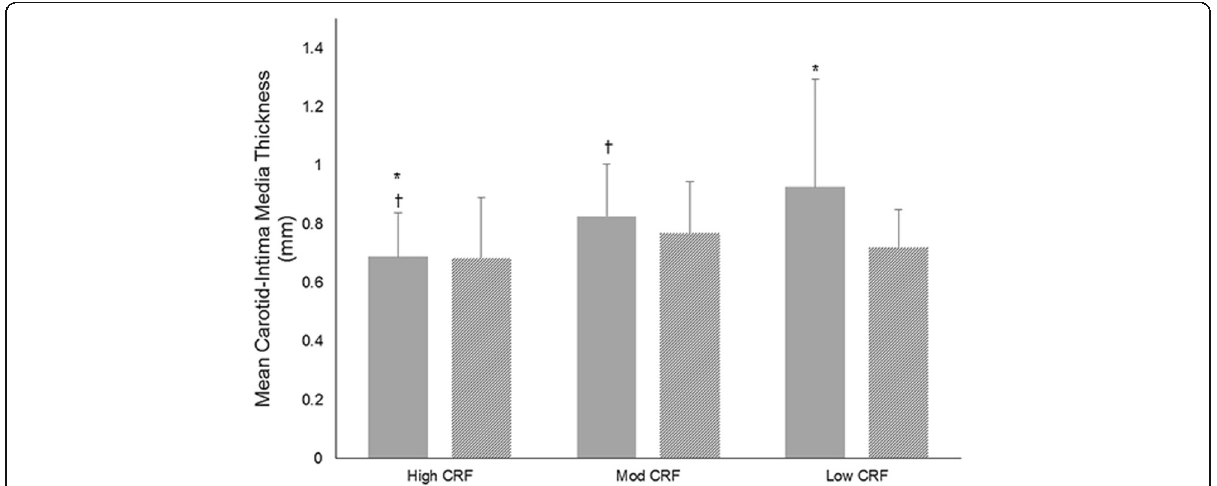
Fig. 1 Carotid intima-media thickness measurements in low, moderate, and high cardiorespiratory fitness groups. Mean left-sided carotid intima-media thickness measurements (solid grey bars) were higher in the low and moderate cardiorespiratory fitness categories. Mean right-sided carotid intima-media thickness (lines) did not differ between groups. Mod = moderate; CRF = cardiorespiratory fitness *Significant difference between high CRF and low CRF; ✝ Significant difference between high CRF and moderate CRF